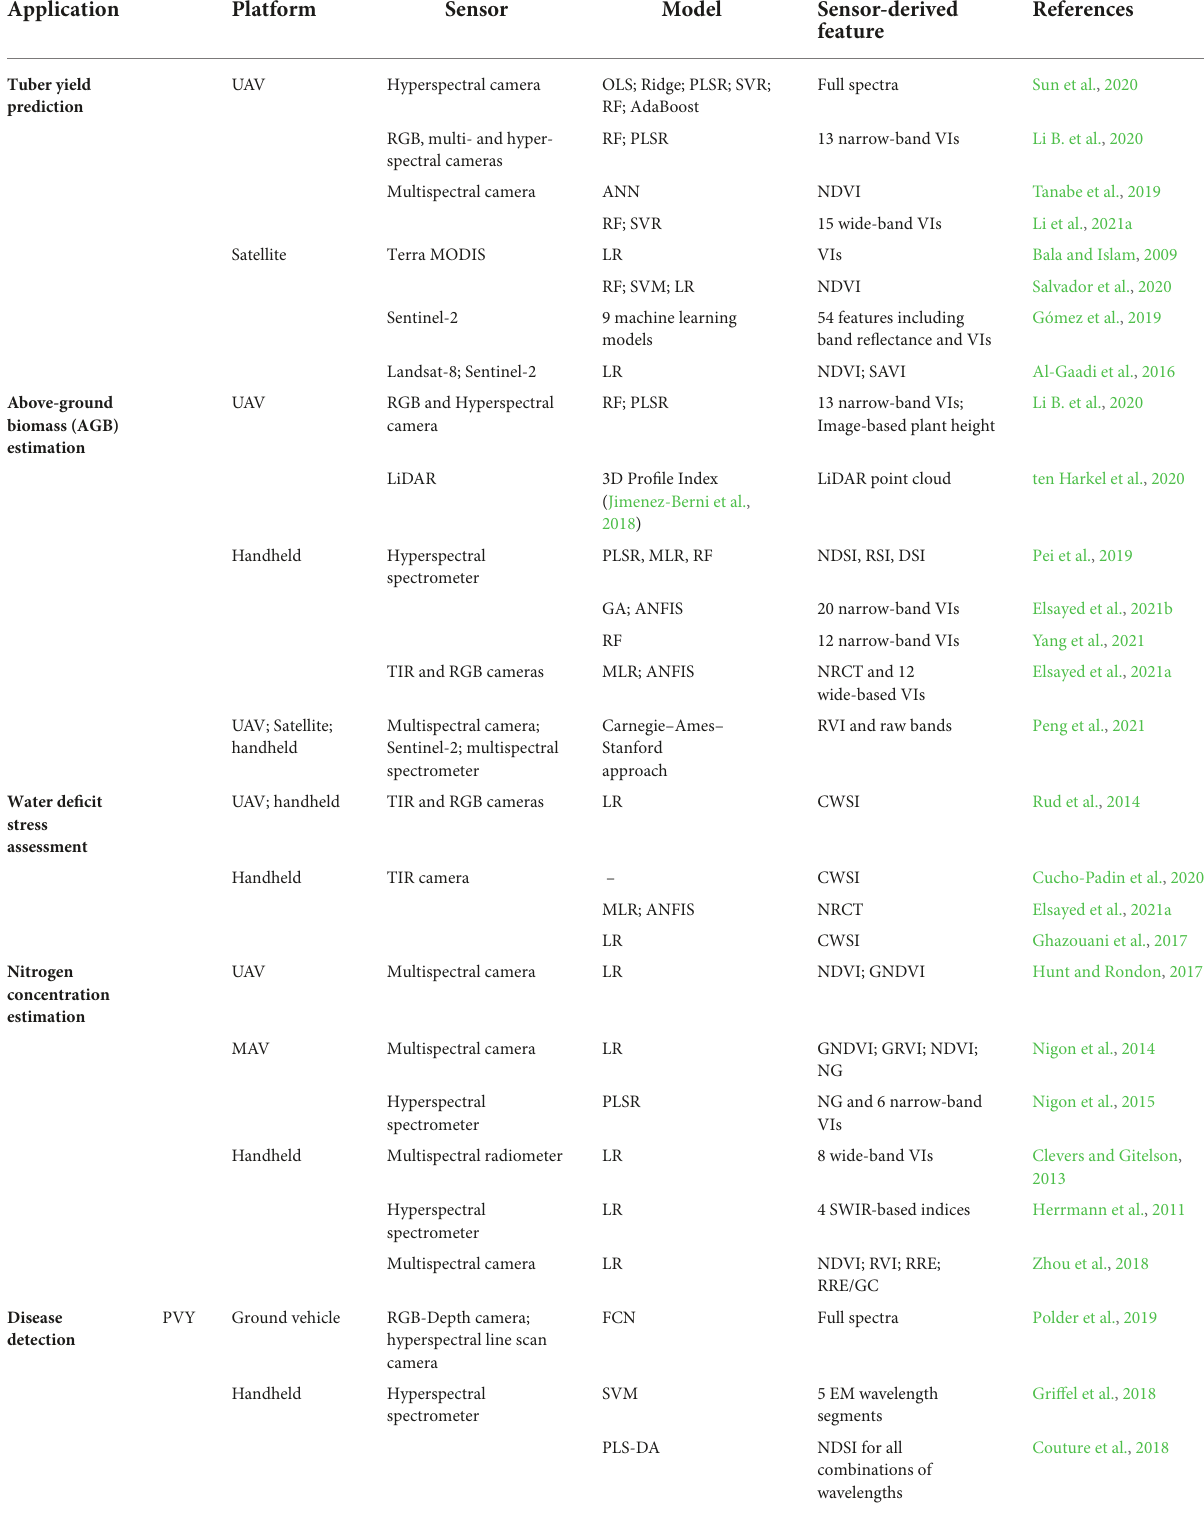
TABLE 4 Applications of remote sensing technologies in Potato traits